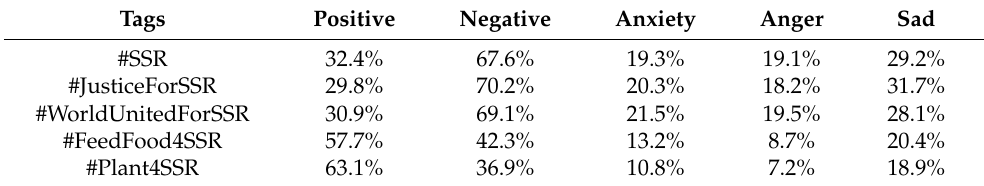
Table 7. Percentages of Emotion